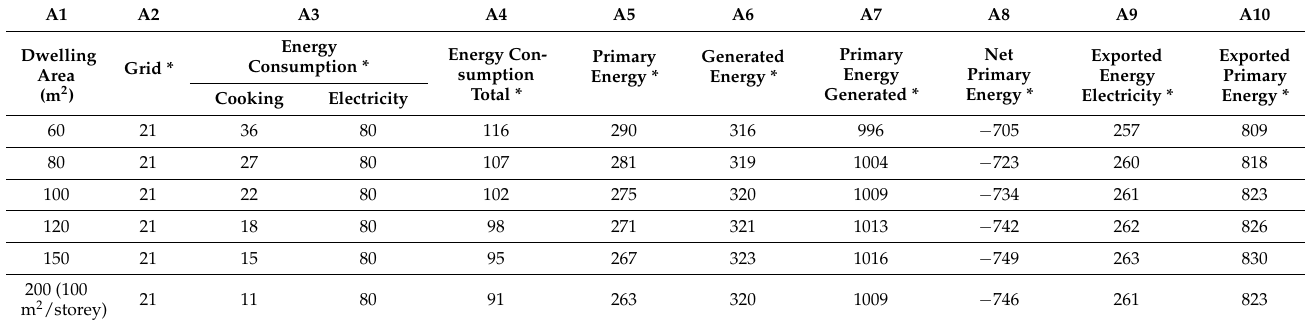
Table 6. Energy consumption and balance in typical residential building.